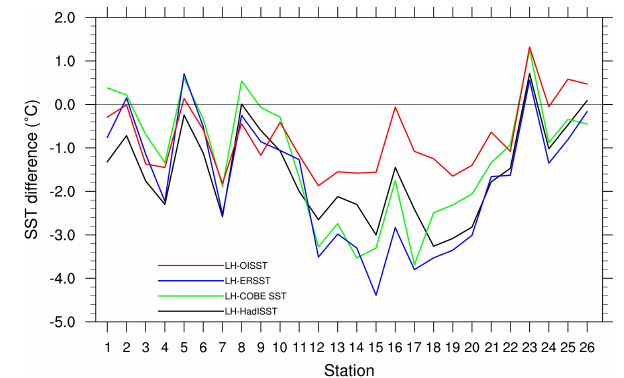
Figure 7. Simulated SSTs at different distances from each coastal hydrological station in the South China Sea. Figure 8. The mean SST differences at the 26 locations between LH and LA-OISST (1982–2015; red line), LH and LA-ERSST (1960– 2015; blue line), LH and LA-COBE SST (1960–2015; green line), and LH and LA-HadISST (1960–2015; black